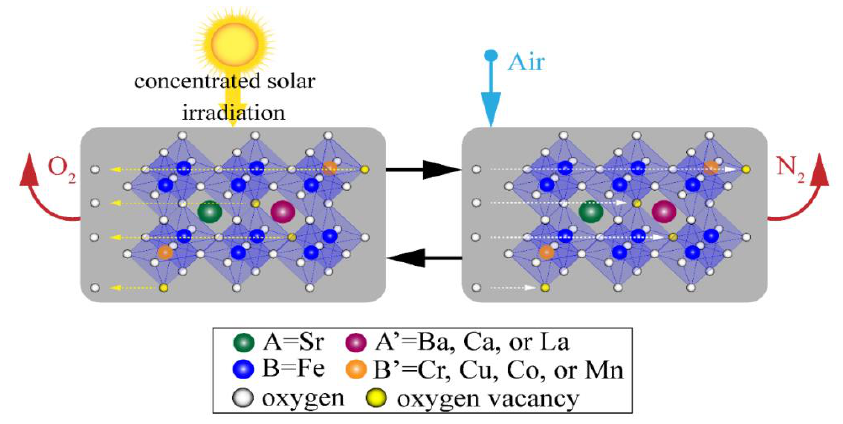
Figure 1. Schematic of the two-step solar thermochemical air separation cycle based on reversible reduction/oxidation SrFeO 3−δ perovskite reactions with different A- and/or B-site substitutions.